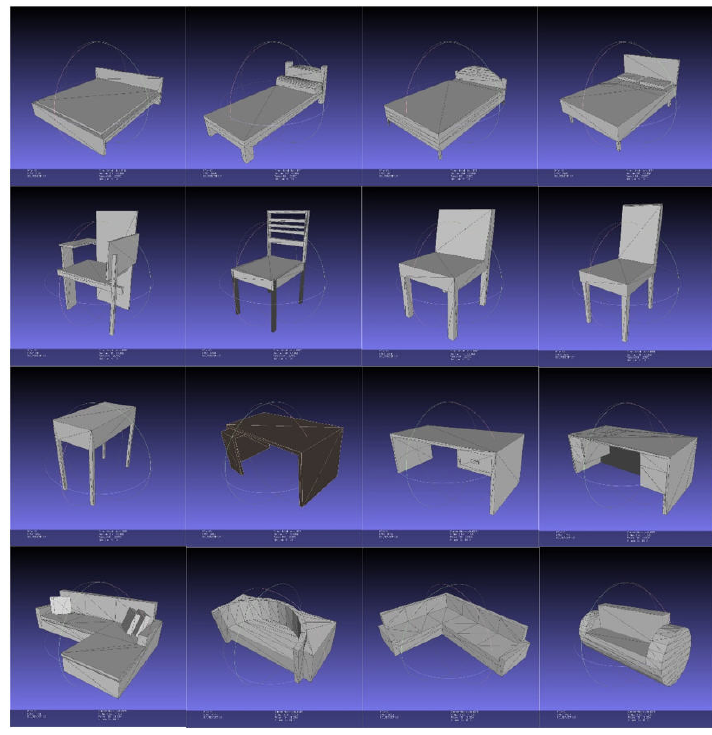
Figure 11. Princeton Modelnet10 data (under 300